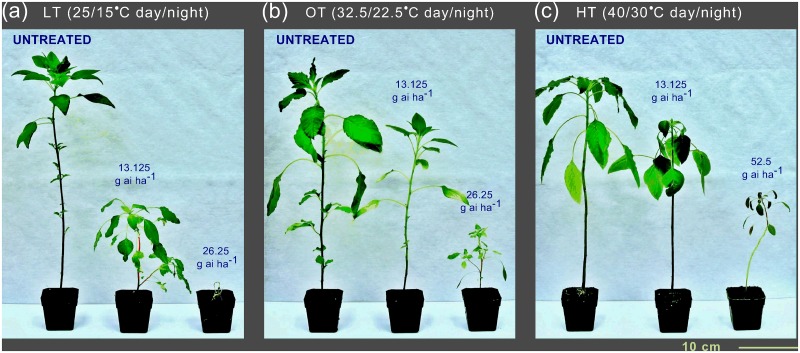
Photographs of mesotrione-treated Palmer amaranth plants grown under (a) LT (25/15°C, day/night), (b) OT (32.5/22.5°C, day/night), and (c) HT (40/30°C, day/night) conditions (15/9 h day/night).Plant to plant variability was observed within the growth temperature and mesotrione rate. These are the representative plants for each dose and temperature. The photographs were taken 4 weeks after treatment and all photographs were taken under the same magnification.